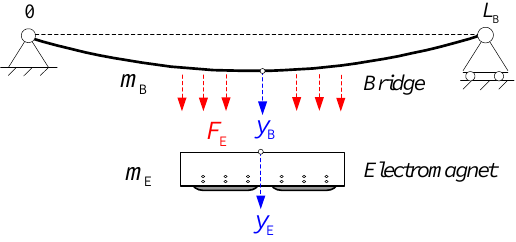
Figure 1. The minimum model of Maglev vehicle-bridge system. Red arrows: F E is electromagnetic force; blue arrows: y B and y E are the vertical displacements of bridge and electromagnet. For a simply supported bridge, the first modal frequency ω B and modal shape functions φ B ( x ) are (cid:112) = λ 2 ω EI B / ρ B B